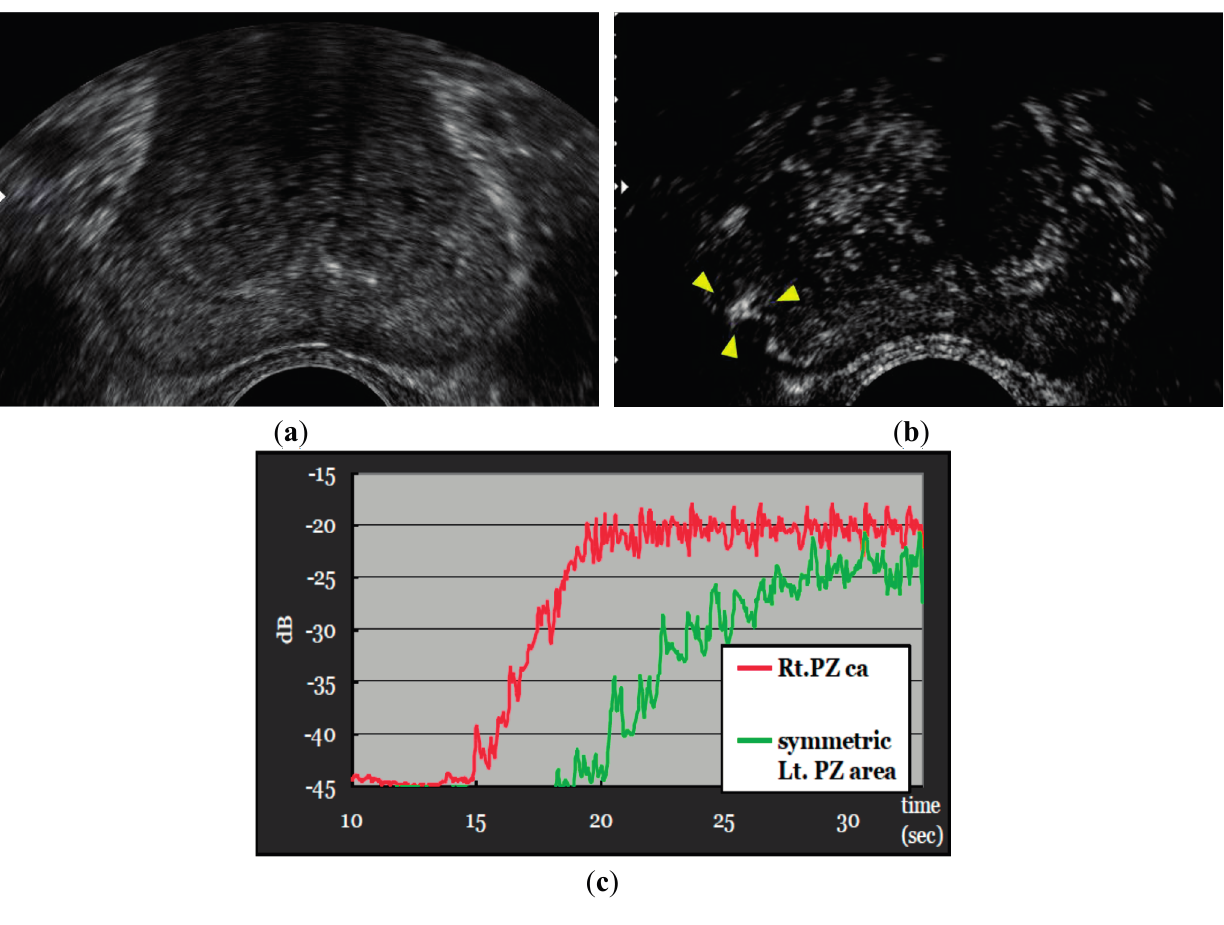
Figure 2. Patient with a PSA level of 7.4 ng/mL. Strong and rapid contrast enhancement was noted in the PZ of the right lobe. Biopsies of the corresponding region resulted in Gleason score of 3 + 3. The time intensity curve showed the early contrasting effect of the cancerous lesion in comparison with the symmetric normal tissue of the left lobe. Gleason score of 4 + 3. ( a ) Gray scale; ( b ) CEUS; ( c ) time intensity curve. The pathologic evaluation of radical prostatectomy specimens is essential for cancer foci detection (Table 1). Matsumoto et al. compared radical prostatectomy specimens with pre-operatively performed grayscale US, power Doppler and harmonic imaging CEUS. In the 50 prostate glands studied, a total of 104 PCa foci were found at pathologic evaluation. Grayscale imaging demonstrated 21 (20.2%) and CEUS imaging demonstrated 32 (30.8%) of these foci [13]. Strazdina et al. conducted a similar study in 50 patients who were scheduled to undergo radical prostatectomy. Grayscale US demonstrated 34 of the 72 cancer foci (47.2%), and CEUS demonstrated 44 foci (61.1%) [14]. These results indicate that CEUS provides improved PCa detection compared to conventional grayscale. However, the sensitivity of CEUS is lower in cases of small low-grade tumors and centrally located